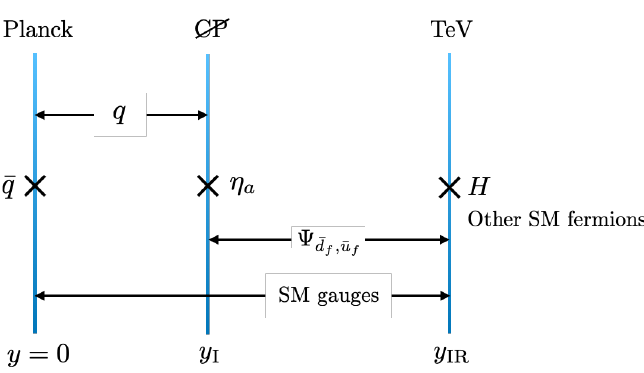
Figure 1 . A schematic picture of the setup. Here, q denote q u and q d while ¯ q denote ¯ q u and ¯ q d